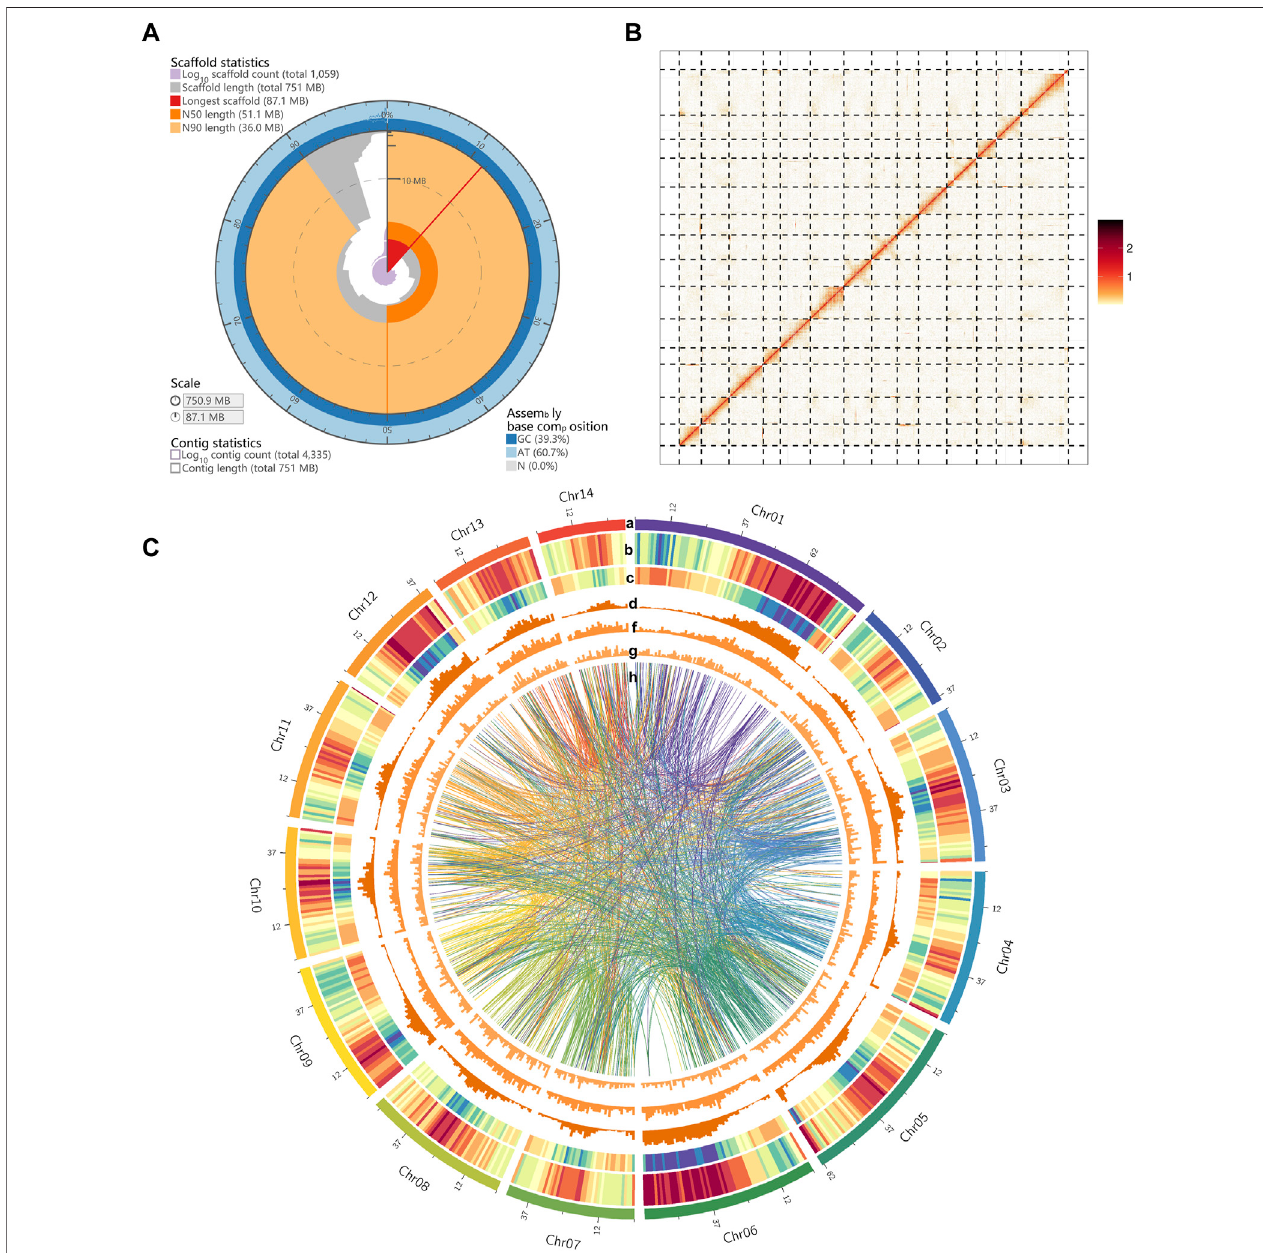
FIGURE 1 | Landscape of macadimia genome. (A) Visualization of assembly stats (https://github.com/rjchallis/assembly-stats): the inner radius (highligthed in red color) represents the length of the longest scaffold, the radial axis originates at the circumference indicates the scaffold length, the N50 and N90 scaffold lengths are indicated respectively by dark and light orange arcs, respectively. The cumulative number of scaffolds within a given percentge of the genome is plotted in purple. The outermost circular layer shows the base composition at the given coverage of the genome. (B) Hic-contact map of macadimia genome. (C) Circos plot of macadimiagenome.Tracksfromoutsidetoinsidearethe14chromosomesof M.tetraphylla ,genedensity(densitymeasuredin1000-Kbslidingwindows),transposable element (TE) density, Gypsy -type LTR retrotransposons density, Copia -type LTR retrotransposons density, DNA transposable element density. The syntenic blocks within chromosomes of macadimia genome are displayed with connecting lines in different colors.